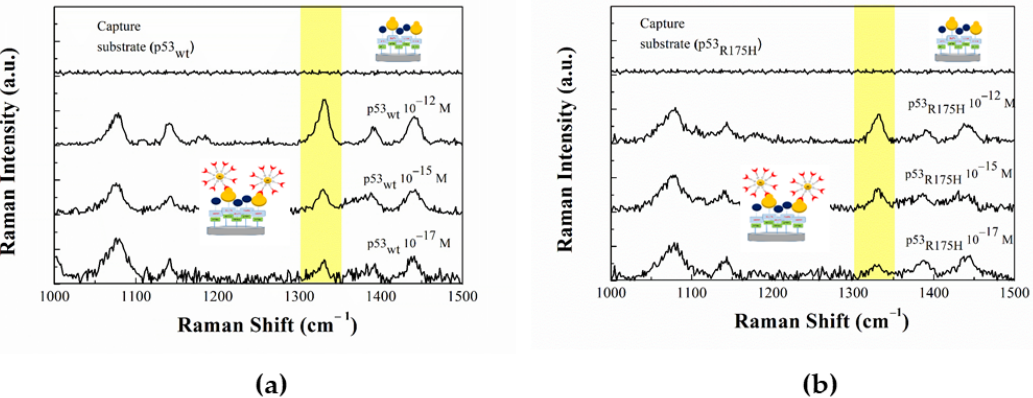
Figure 8. ( a ) Raman spectra of the capture substrate, functionalized with p53 wt at different concentra- tions, before and after incubation with the 4-ATP-NP-pro probe charged with antip53 wt . ( b ) Raman spectra of the capture substrate functionalized with p53 R175H , at different concentrations, before and after the incubation with the 4-ATP-NP-pro probe charged with antip53 R175 . The yellow band high- lights the Raman marker peaked at 1328 cm −1 .